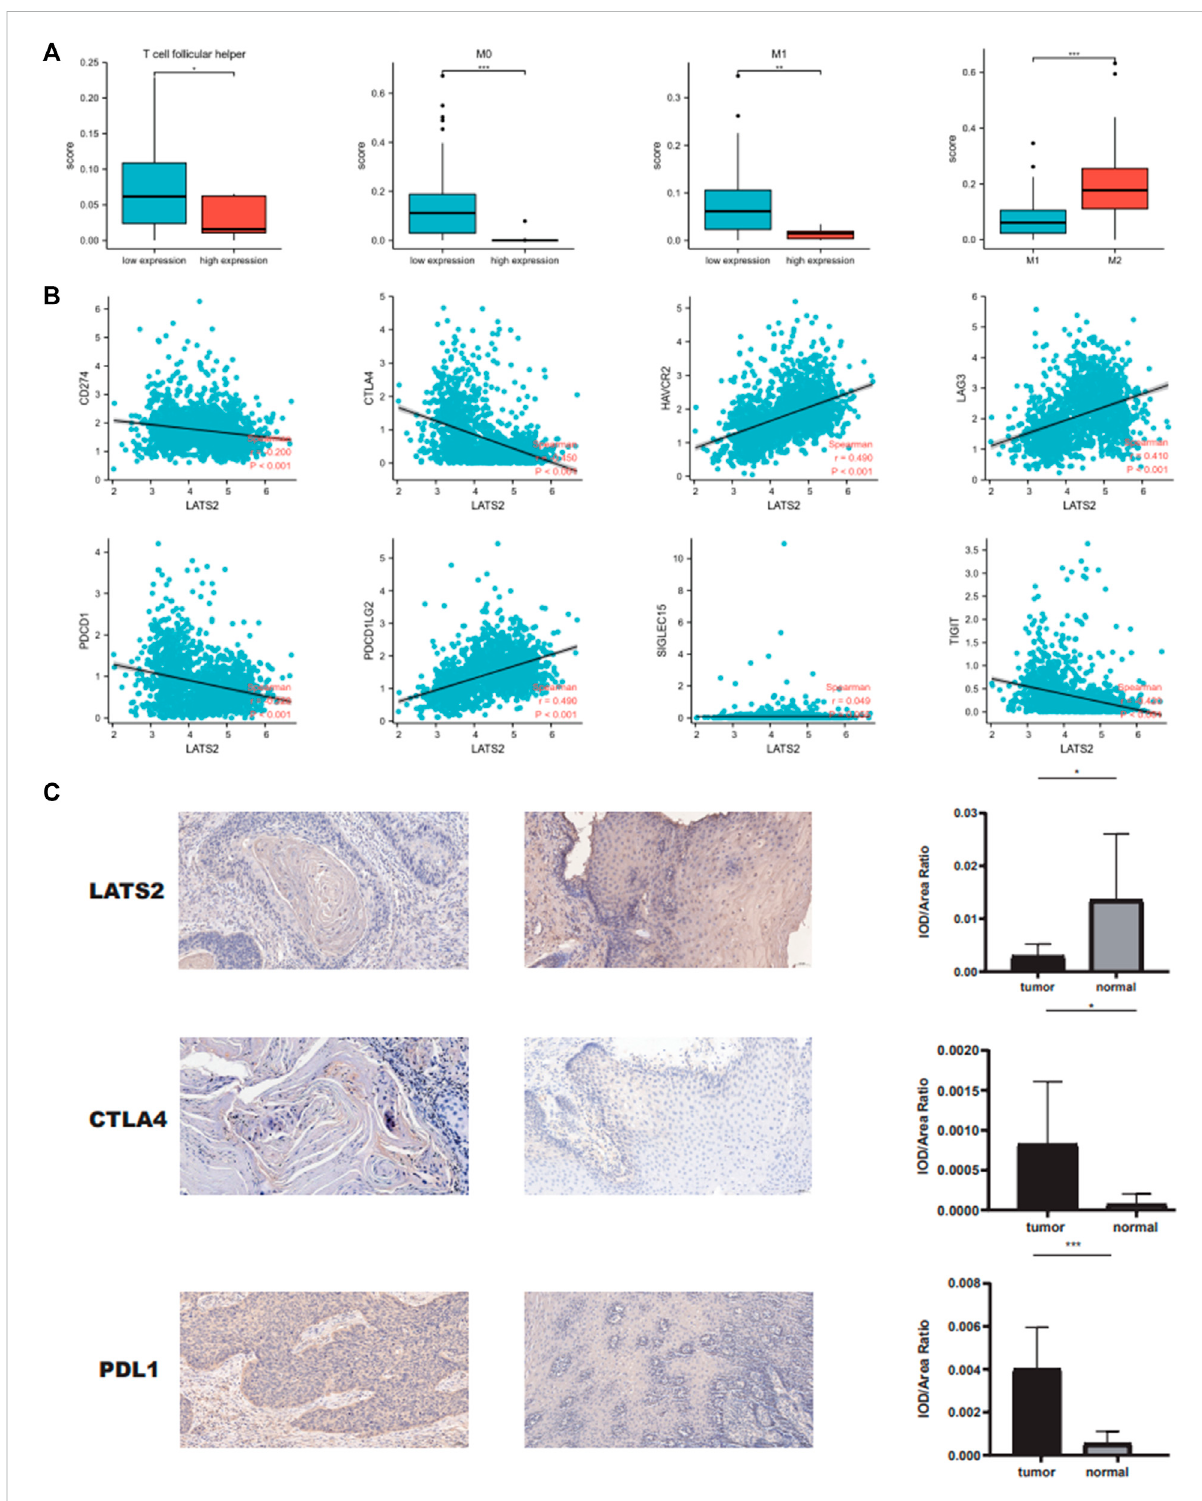
FIGURE 6 (A) LATS2 expression correlated with numbers of immune cells. (B) Correlation between LATS2 expression and immune checkpoints. (C) IHC staining of LATS2, CTLA4, and PD-L1 in ESCC